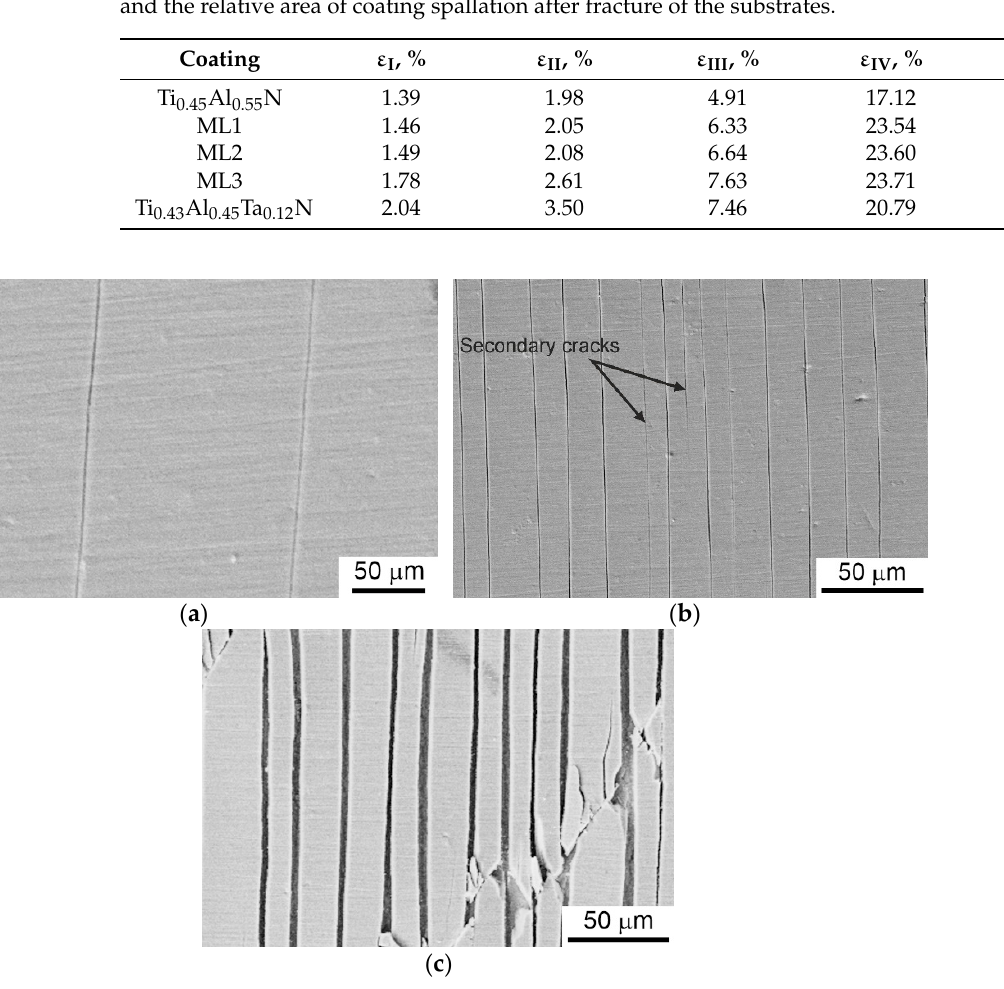
Figure 3. Different failure stages of the Ti 0.45 Al 0.55 N coating: a—primary cracking (stage I); b—secondary cracking (stage II); c—diagonal cracking (stage III). The SEM micrographs correspond to ( a ) 1.4%; ( b ) 2.0%; and ( c ) 5.0% substrate elongation.